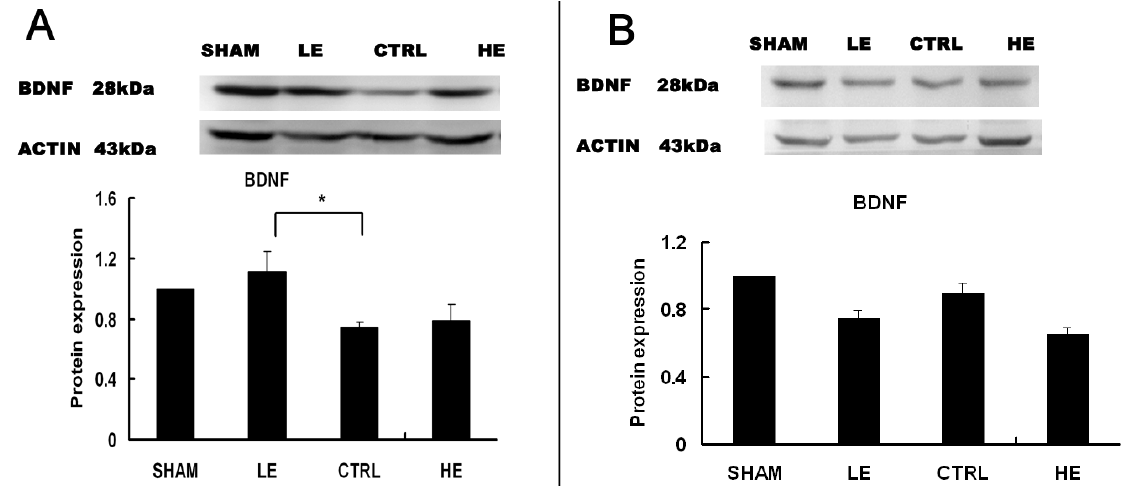
Figure 4. Effects of treadmill exercise on hippocampal BDNF. ( A ) The levels of BDNF were significantly increased in the low intensity exercise group (LE) compared with the control group (CTRL) in the contralateral hippocampus. The levels of BDNF were similar in the HE and CTRL groups ( p > 0.05). * p < 0.05 compared to the control group; ( B ) The levels of BDNF were increased in the control group (CTRL) compared to the low intensity exercise group (LE) or high intensity exercise group (HE) in the ipsilateral hippocampus; there was no statistically significant difference between the three groups ( p > 0.05). The data are represented as the means ± SEM.